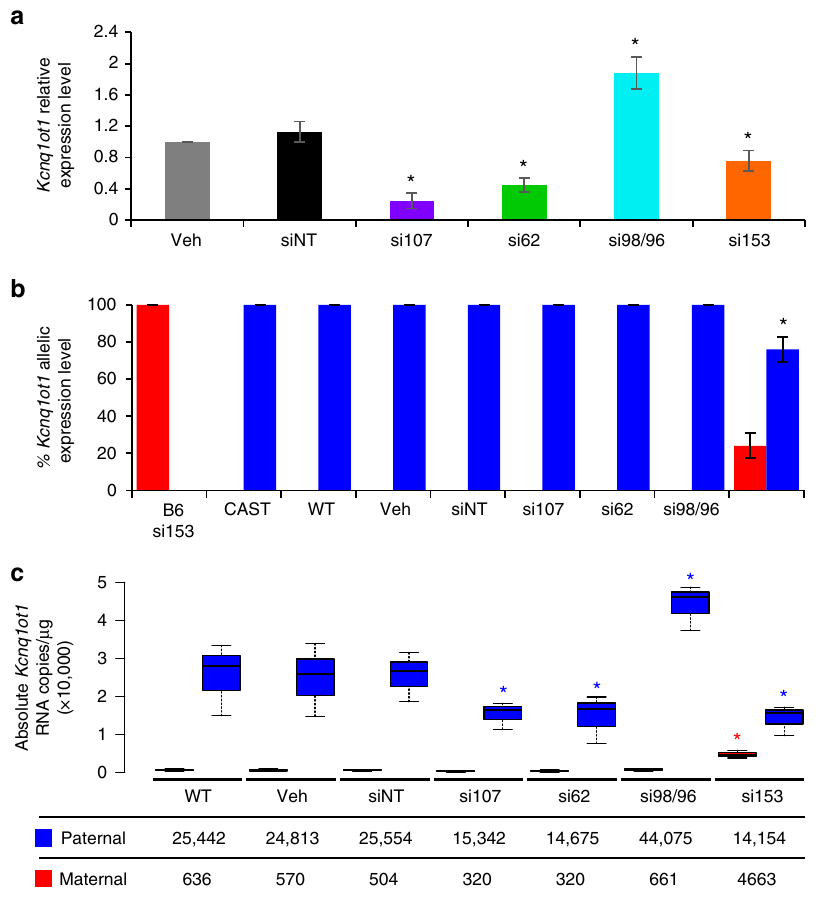
Fig. 1 Nucleoporin depletion disrupted Kcnq1ot1 ncRNA expression. a Real-time Kcnq1ot 1 ncRNA expression levels normalized to Gapdh ( n = 3